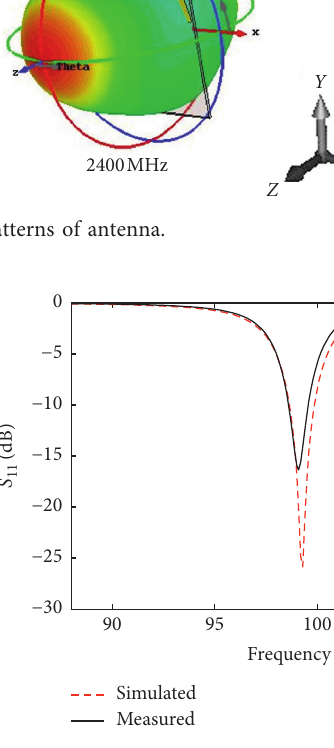
of loaded monopole 11